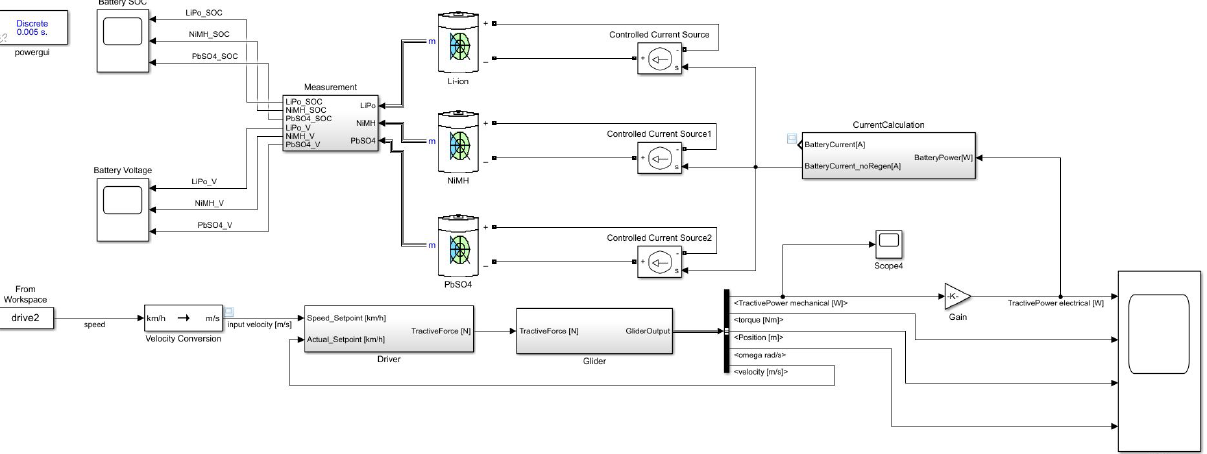
Fig. 4. The general view of the developed MatLab model.